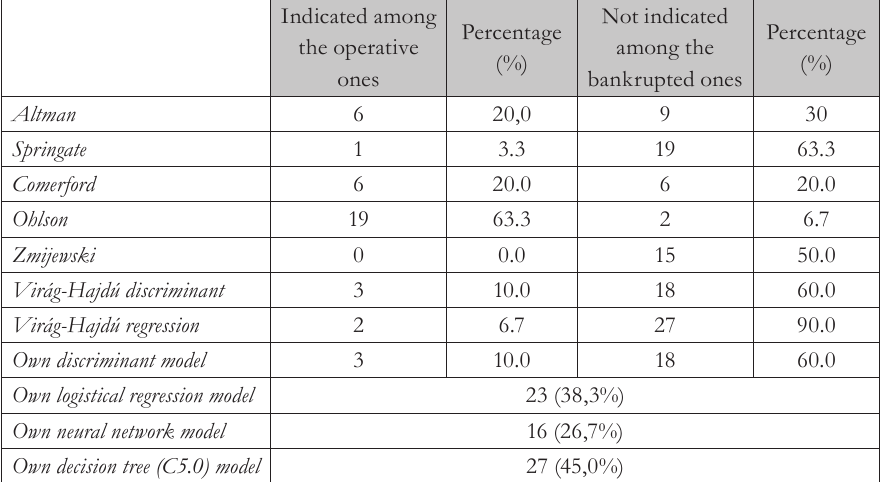
Tab. 5 – The failure values of crisis management models regarding the validity sample. Source: own